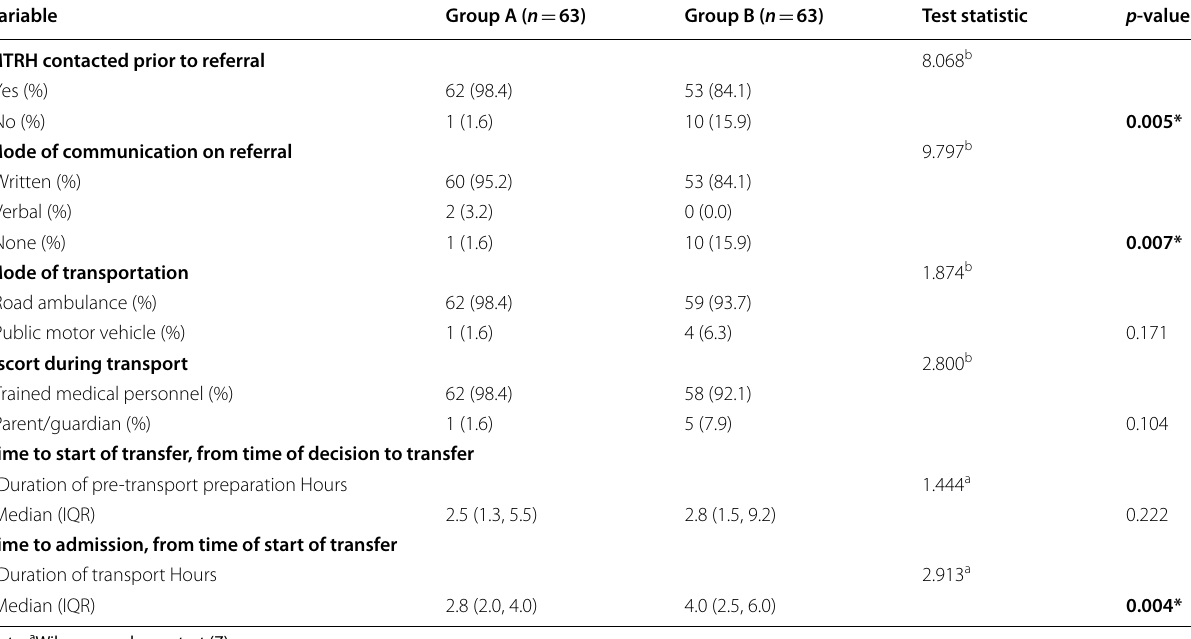
Table 2 Distribution of the newborns according to their referral and transport characteristics